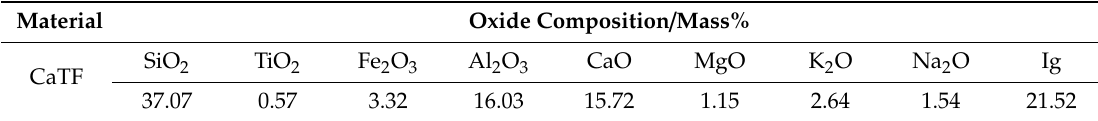
Table 5. Chemical composition of sample CaTF.